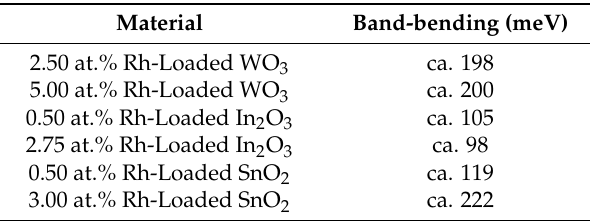
Table 2. A list of the calculated band-bending values.